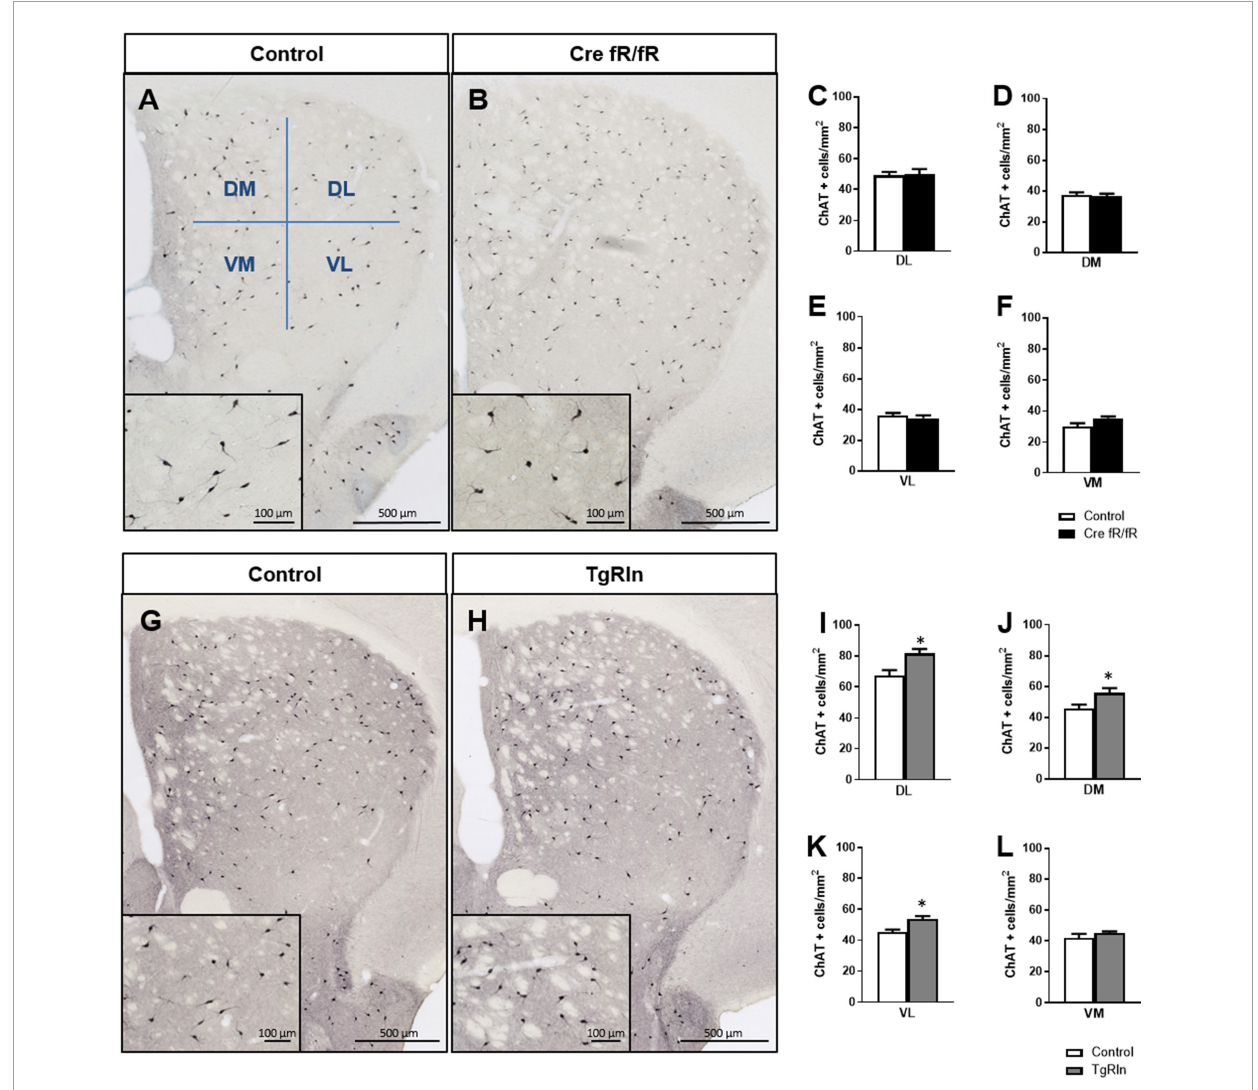
FIGURE3 Reelin overexpression increases the density of striatal cholinergic interneurons. (A,B) Immunohistochemistry of ChAT in striatal coronal sections of control and Cre fR/fR mice, with representative subdivision of the striatum in four regions (DM, dorsal-medial; DL, dorsal-lateral; VM, ventral-medial; VL, ventral-lateral). (C–F) Quantification of ChAT+ neurons density in the striatal subdivisions shows no differences between control and Cre fR/fR mice ( n = 4). (G,H) Representative images of ChAT immunohistochemistry in the striatum of control and TgRln mice, with higher magnification insets showing increased ChAT+ neuronal density in the TgRln mice. (I–L) Quantification of ChAT+ cell density indicates a significant increase in the DL, VL, and DM striatal regions of TgRln mice ( n = 4–6). Scale bar: (A,B,G,H) , 500 µ m; high magnification insets 100 µ m. Statistical analyses were performed using Student’s t -test; * p < 0.05. Data are represented as means ±